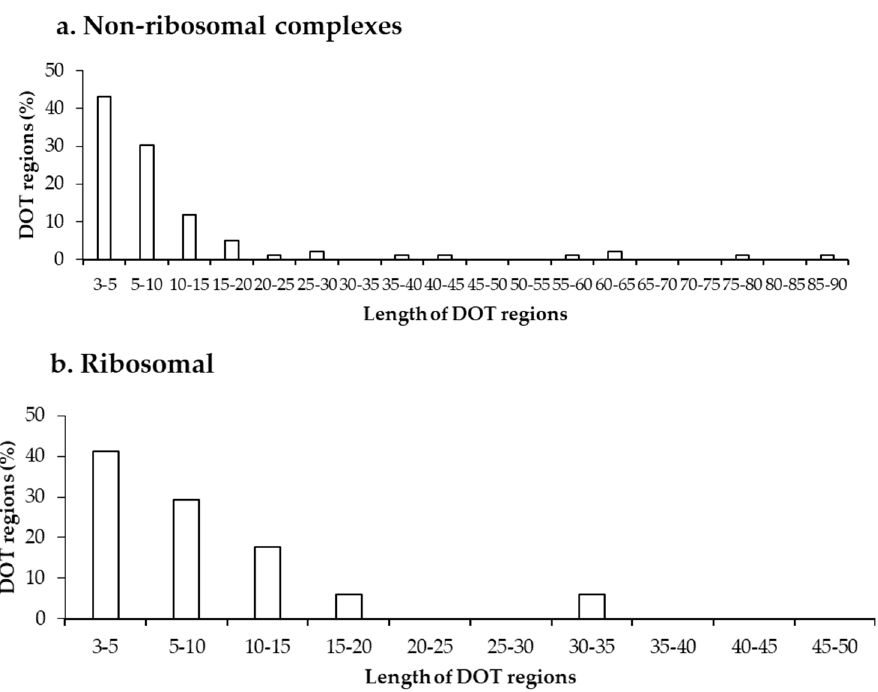
Figure 2. Length distribution of DOT regions in protein–RNA complexes in ( a ) non-ribosomal and ( b ) ribosomal complexes.